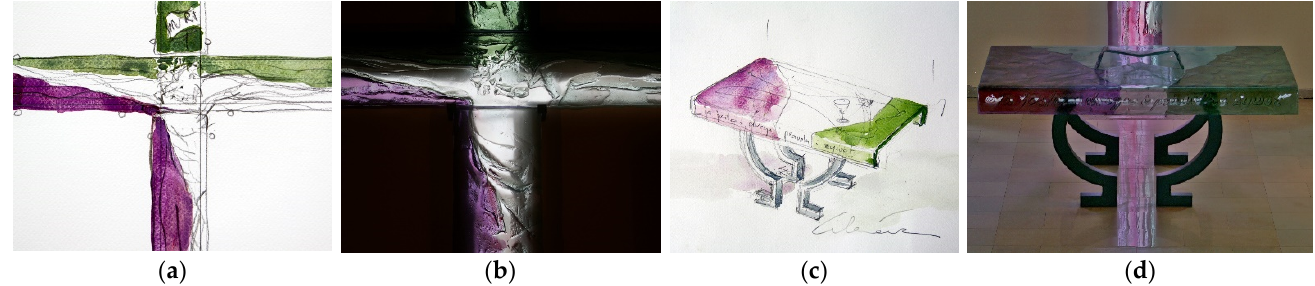
Figure 17. Details of glass elements with religious symbolism: ( a ) part of the crucifix design; ( b ) corresponding final glass appearance; ( c ) altar design; ( d ) the complete glass altar with a visible effect of reflections on the floor (Tomasz Urbanowicz).